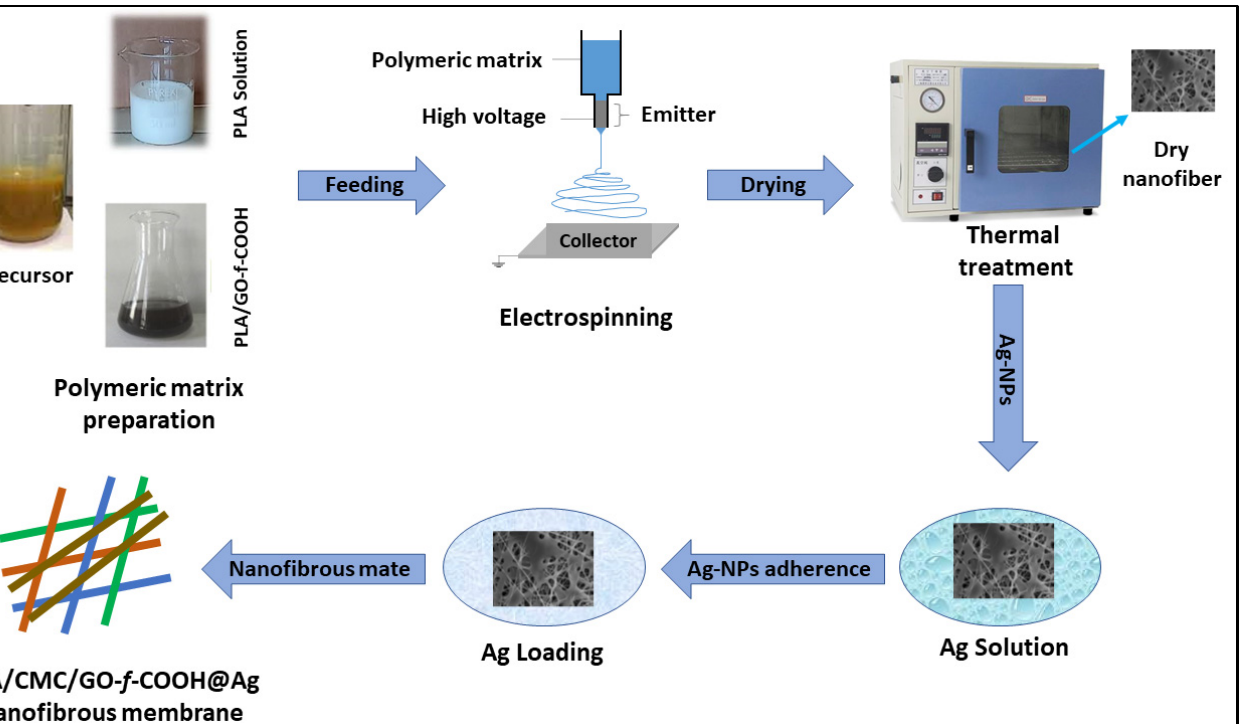
Figure 1. Schematic diagram representing the preparation of a polymeric matrix with which to fabricate nanofibers via electrospinning with thermal treatment, followed by the synthesis of the nanofibrous membrane.